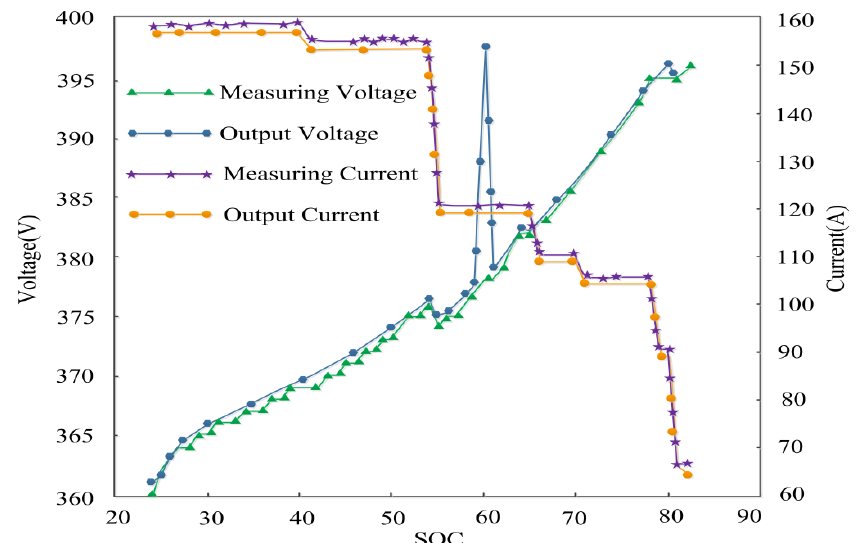
Figure 11. While the battery model is a lithium iron phosphate battery, the curve diagram of the measured voltage, output voltage, and measured current output current during the charging process of an EV is in an abnormal state.